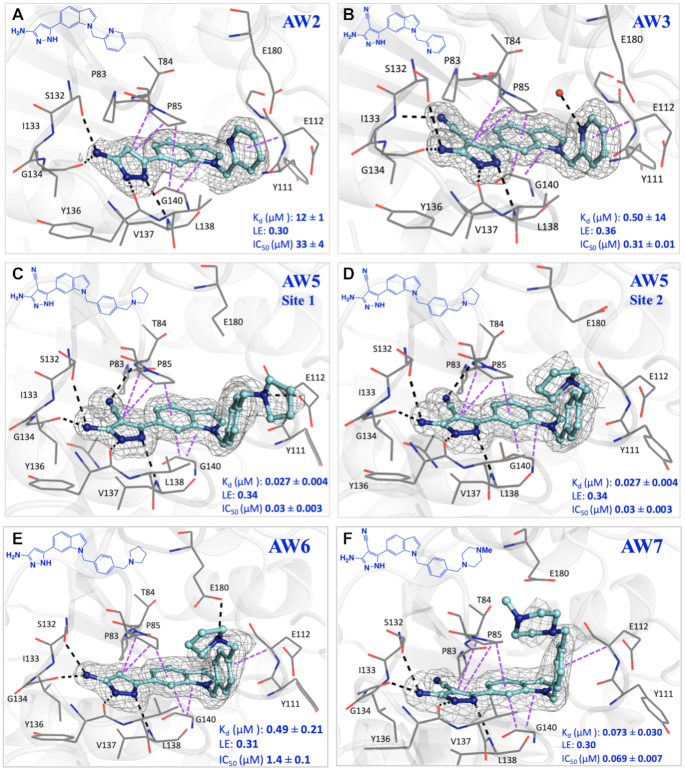
X-ray crystal structure of TrmD (grey) in complex with compounds (A) AW2, PDB Code 6QQX (B) AW3, PDB Code 6QQY (C) AW5 at protomer 1, PDB Code 6QR6, (D) AW5 at protomer 2, PDB Code 6QR6, (E) AW6, PDB Code 6QR5 and (F) AW7, PDB Code 6QR8, showing binding mode at the SAM site. The corresponding amino acid interactions are illustrated with polar hydrogen bond interactions and π-interactions in black and purple dotted lines respectively. The TrmD protein is shown as white cartoon model with the interacting amino acid residues in grey lines, the compounds at the active site are represented in light blue stick model with the corresponding Sigma A-weighted mFo– dFc omit maps in grey mesh representation. The 2D chemical structures of each compound and the corresponding affinity (Kd), ligand efficiency (LE) and inhibition data (IC50) are also shown in the inset in dark blue.